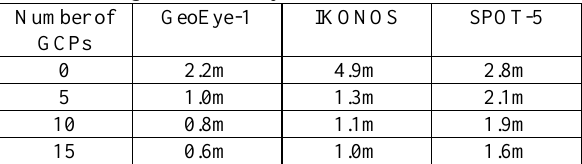
Table 2. Root mean square differences at independent check points based on orientation with manually measured